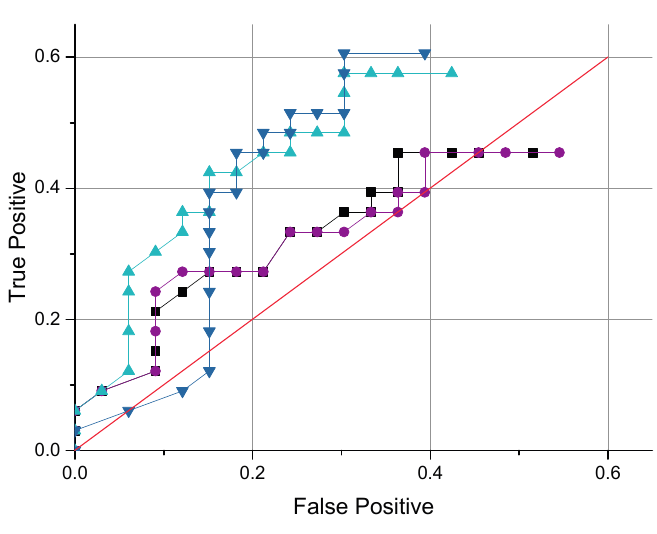
Figure 14. ML system performance plot.